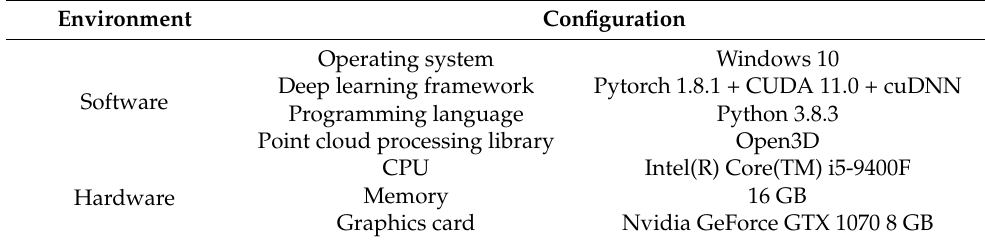
Table 1. Experimental